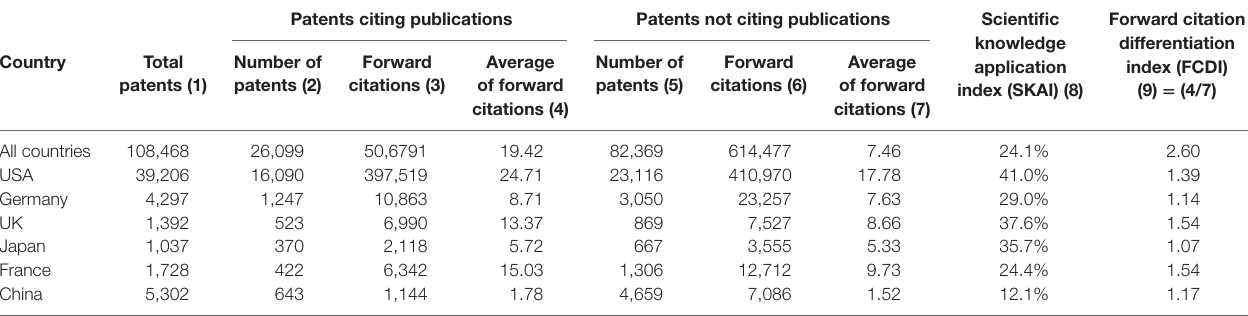
TaBle 2 | Comparison of scientific knowledge application in six studied countries, 2003–2012.